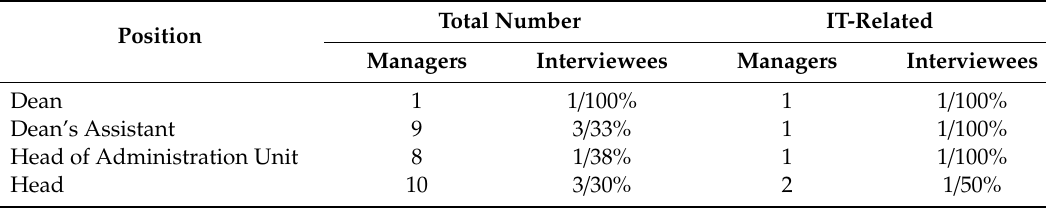
Table 2. Sample distribution per category of